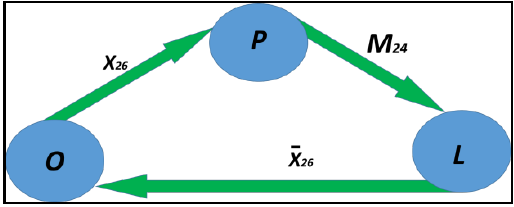
Figure 7. Automatic graph of the valve 24.